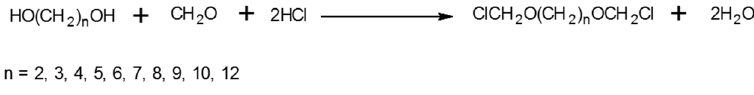
Figure 8. Scheme of α,ω-di(chloromethoxy)alkanes.